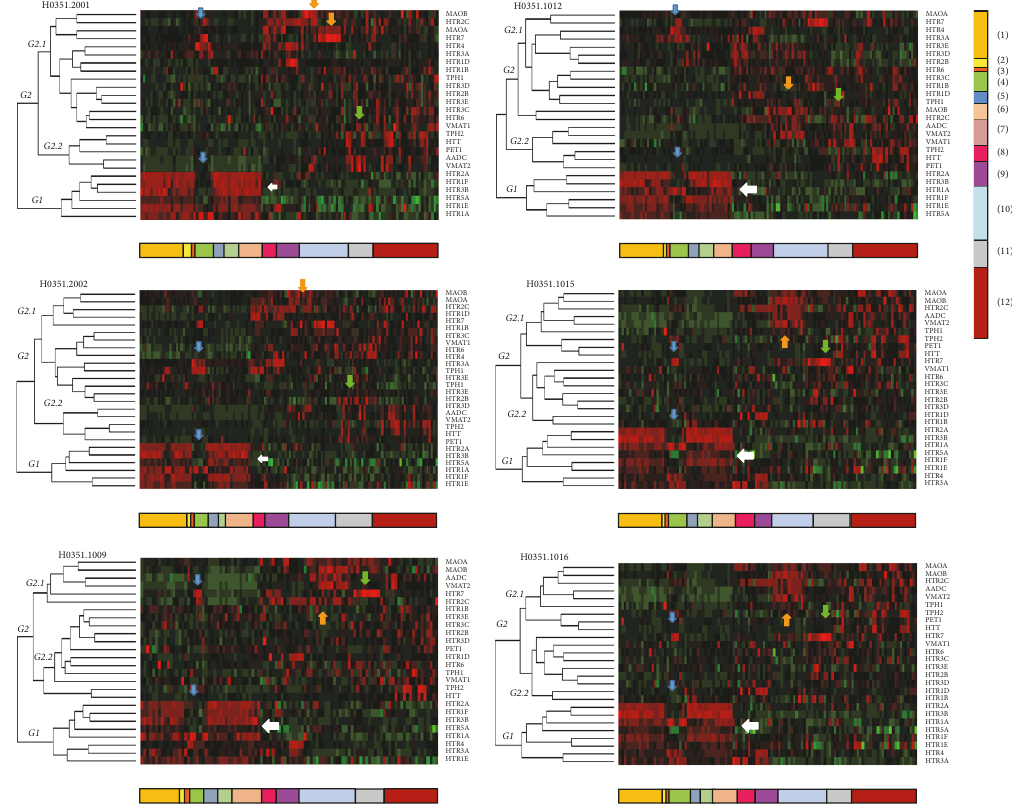
Figure 4: Heatmaps of gene expression of serotonin system in donors. On the left, dendrogram with organization in two main groups (G1 and G2). The second group has two branches or trees. Below each heatmap a color representation of brain structures. The original heatmap for each donor in supplementary images. Group 1 is related to height expression in structures at cerebral cortex in general (white arrow). The hippocampal formation and together structures (dentate gyrus, CA1, CA2, and CA3) present low expression to compare with cortex but height expression in HTR1A gen and HTR4 and HTR7 (blue arrow). The orange arrow shows a group of genes related to inactivation MAOA, for example, and green arrow shows genes related to synthesis and storage. The column on the right has the convention of colors: (1) Frontal Lobe; (2) Insula; (3) Limbic Lobe; (4) Hippocampal Formation; (5) Occipital Lobe; (6) Parietal Lobe; (7) Temporal Lobe; (8) Amygdala; (9) Basal Ganglia; (10) Diencephalon; (11) Mesencephalon; (12)